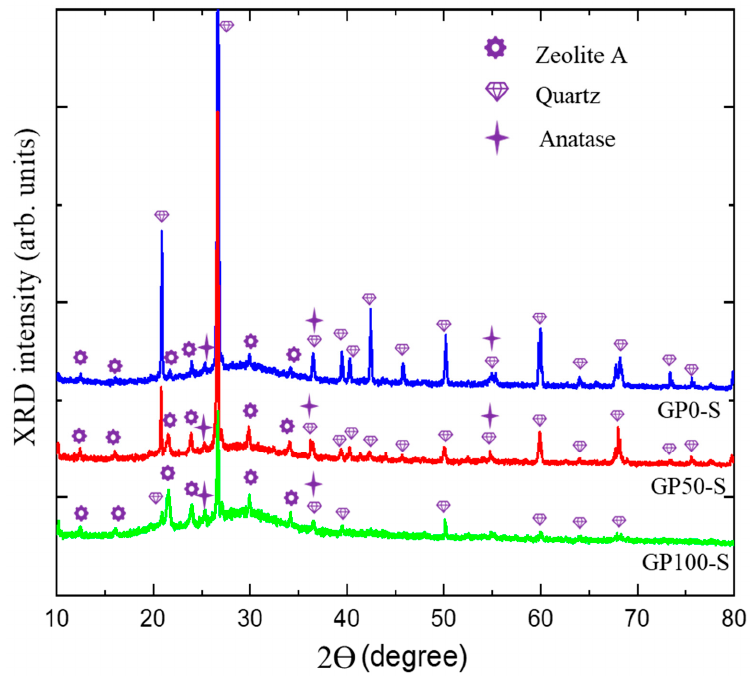
Figure 7. Diffractogram of GP-S group mortars.